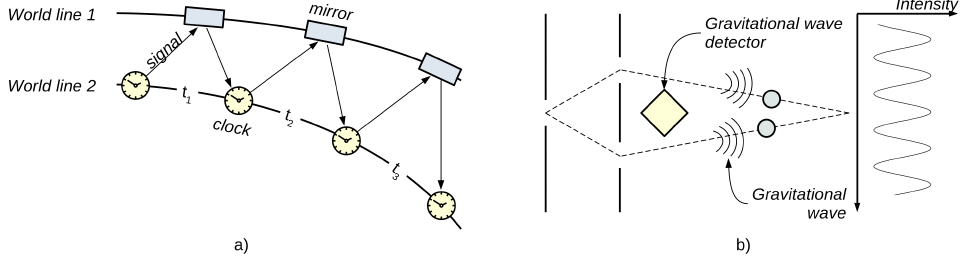
Figure 1. ( a ) Wigner ( b )